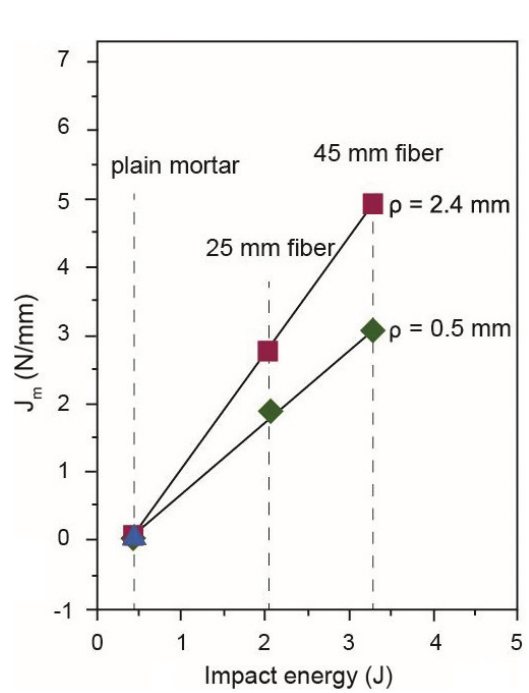
Figure 10. Correlation between J reinforced mortars with notch root radius of 0.5 and 2.4